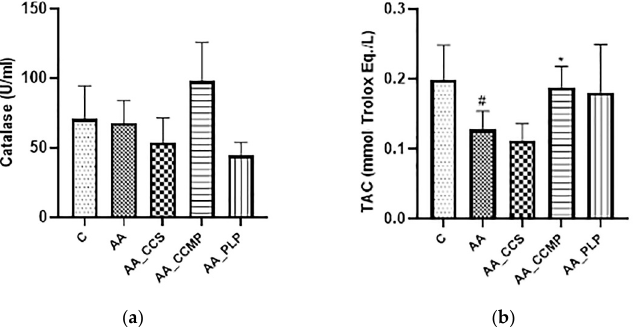
Figure 1. Catalase (CAT) ( a ) and total antioxidant capacity (TAC) ( b ) levels. Data are expressed as the mean ± SD for each group. # p < 0.05 indicates a significant difference in comparison with the control group; * p < 0.05 indicates a significant difference in comparison with the AA group. Abbreviations: C, normal control group; AA, acetic acid group; AA_CCS, curcumin group; AA_CCMP, Col-CUR-MPs group; and AA_PLP, prednisolone group. The bars represent mean values with standard deviations.